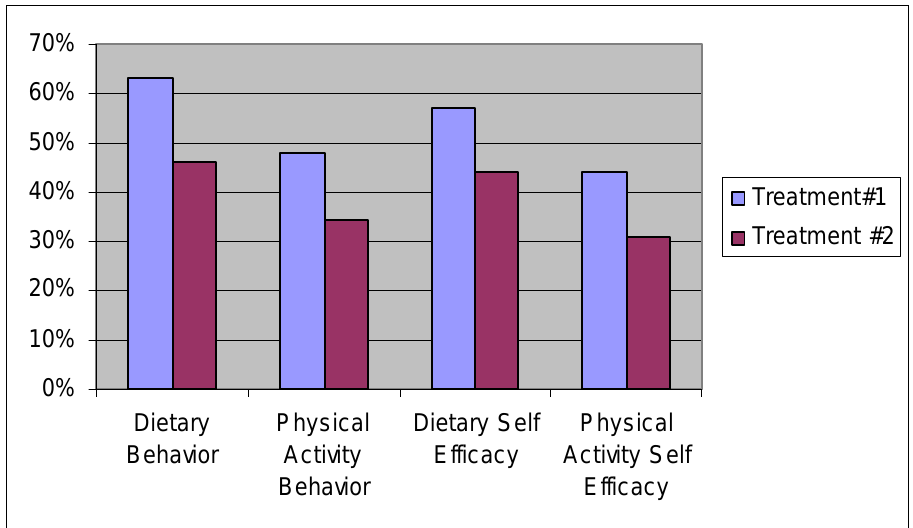
Percent of Treatment #1 and Treatment #2 Participants Who Improved Dietary and Physical Activity Self-Efficacy and Behaviors